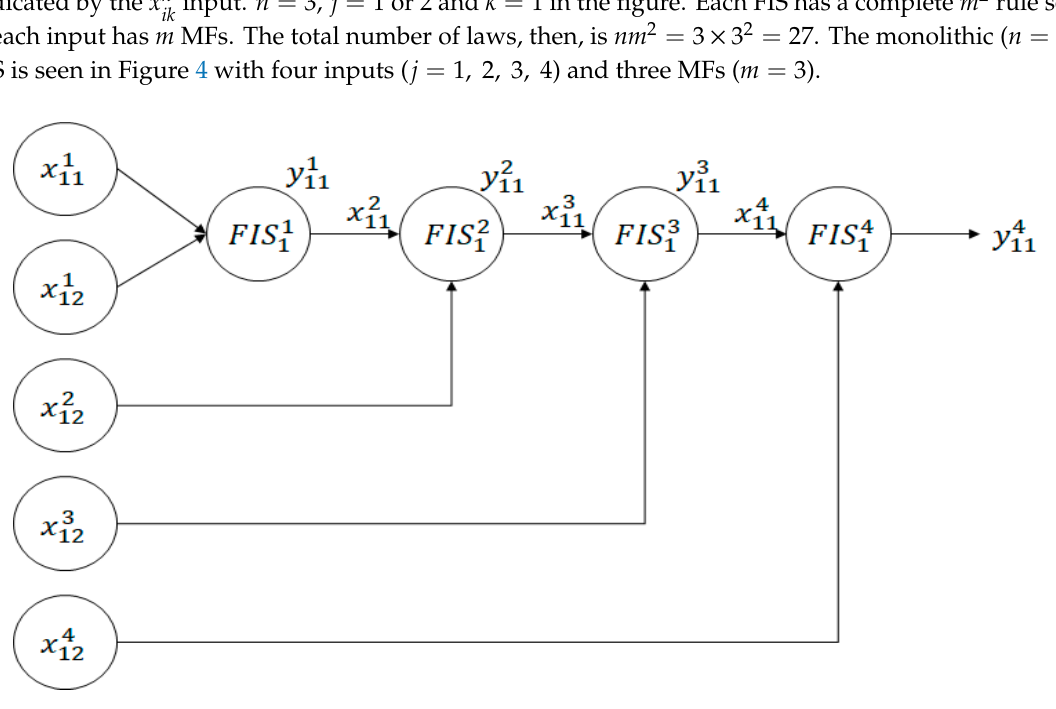
Figure 4. Tree structure in incremental form.